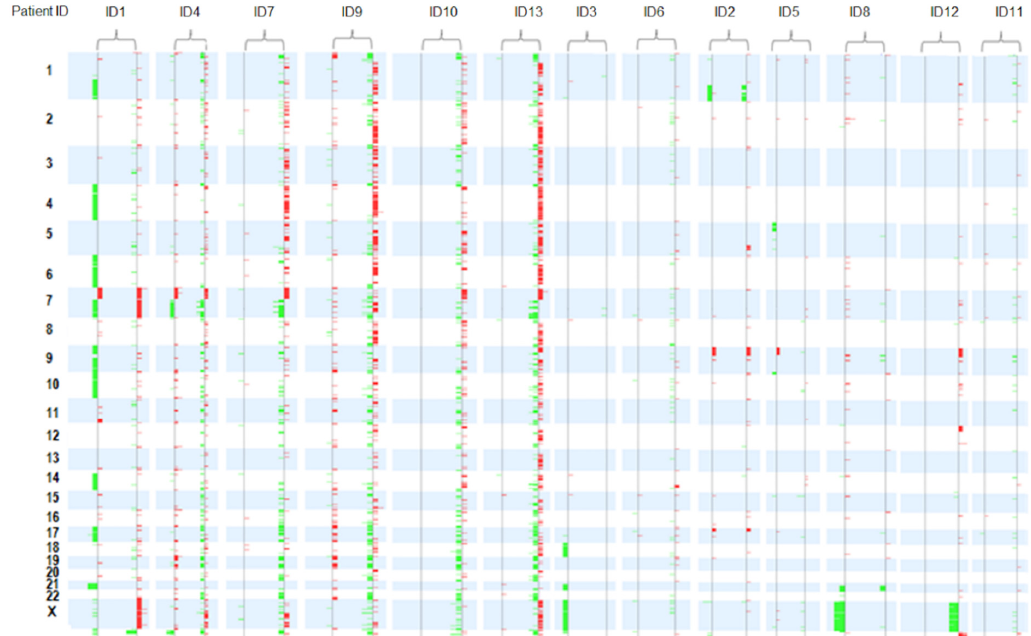
Figure 1. Summary of array comparative genomic hybridization results in 13 paired diagnosis and relapse samples. All patients exhibited heterogeneous changes in the pattern of copy number alterations (CNAs) from diagnosis to relapse. The paired diagnostic/relapse samples were ordered from highest to lowest number of CNAs. Losses: green. Gains: red. Diagnostics 2020 , 10 , x FOR PEER REVIEW